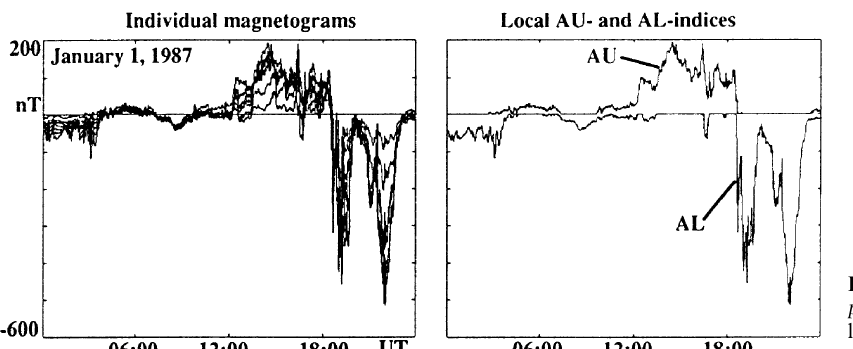
Fig. 2. Construction of the AE indices. ” pper panel : the global AE indices. ‚ ower panel : the local quasi- A ” and A ‚ indices